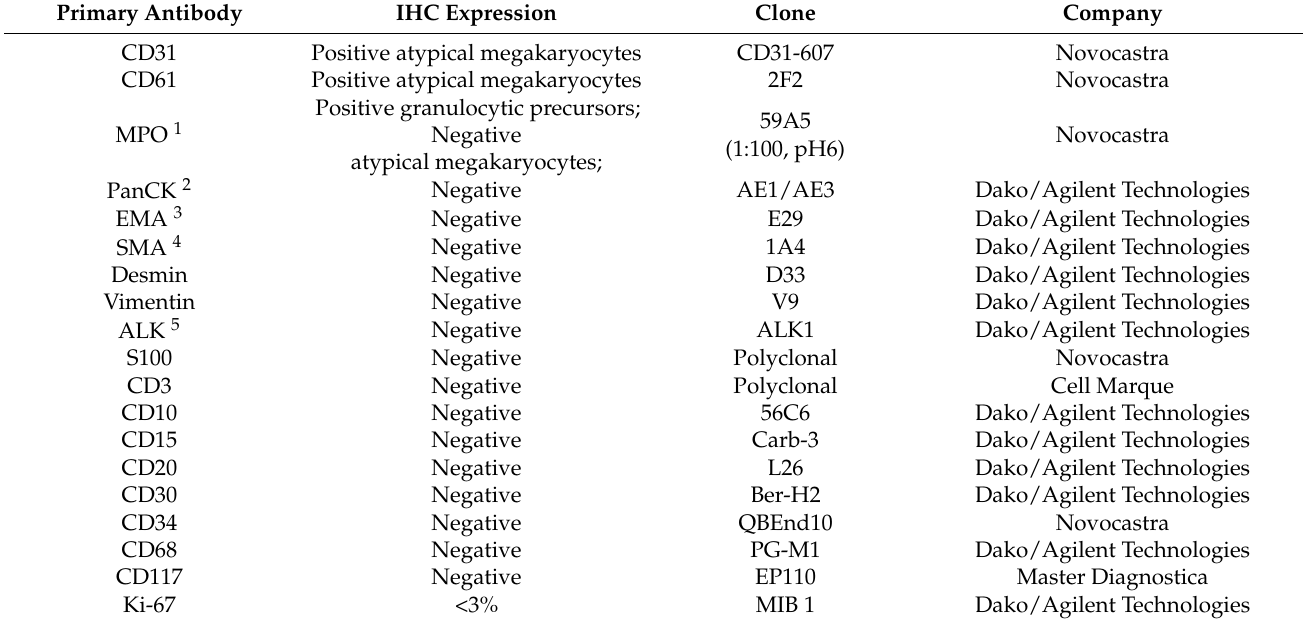
Table 2. Antibodies used to establish the IHC (immunohistochemical) profile of the tumor and their expression. Primary